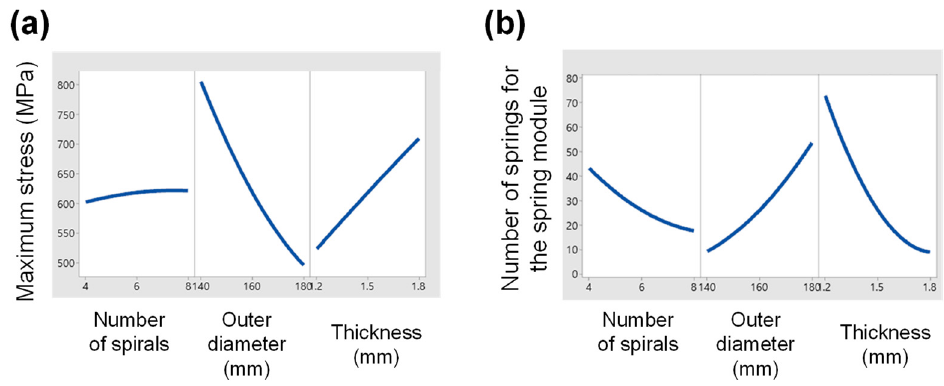
Figure 14. Variation of ( a ) maximum stress and ( b ) number of springs according to design factors such as the number of spiral arms, outer diameter, and thickness.